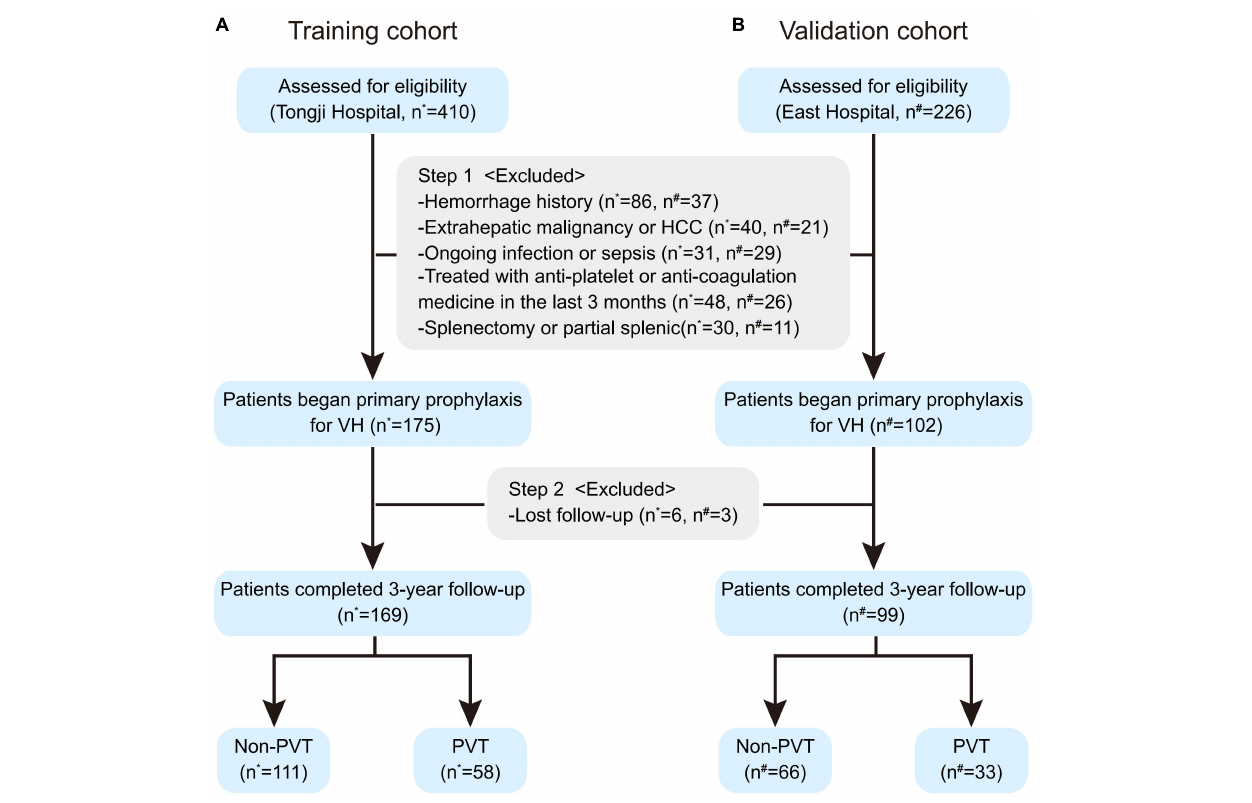
FIGURE 1 | The flow chart of the training (A) and validation cohorts (B) . Patients assessed for eligibility were screened by the inclusion and exclusion criteria and started 3-year follow-up for primary prophylaxis against VH, during which some of these patients were further excluded due to lost follow-up. HCC, hepatocellular carcinoma; PVT, portal vein thrombosis; VH, variceal hemorrhage. ∗ Patients enrolled from Shanghai Tongji Hospital. # Patients enrolled from Shanghai East